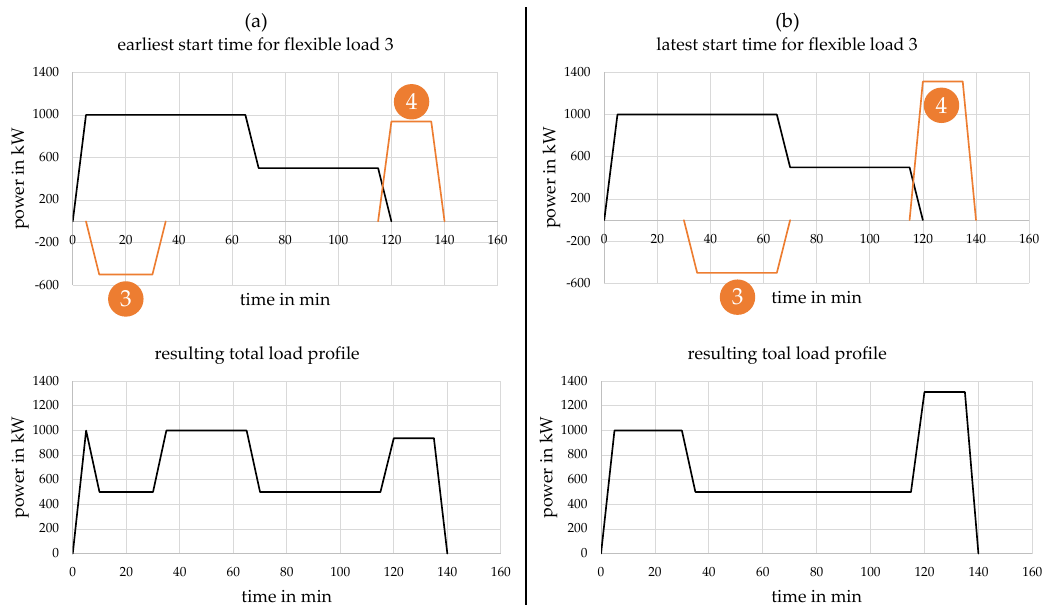
Figure 7. Two possible flexibility measures. ( a ) the flexibility measure for the earliest starting point is depicted on the left-hand side; ( b ) the profiles for the latest point in time are illustrated on the right-hand